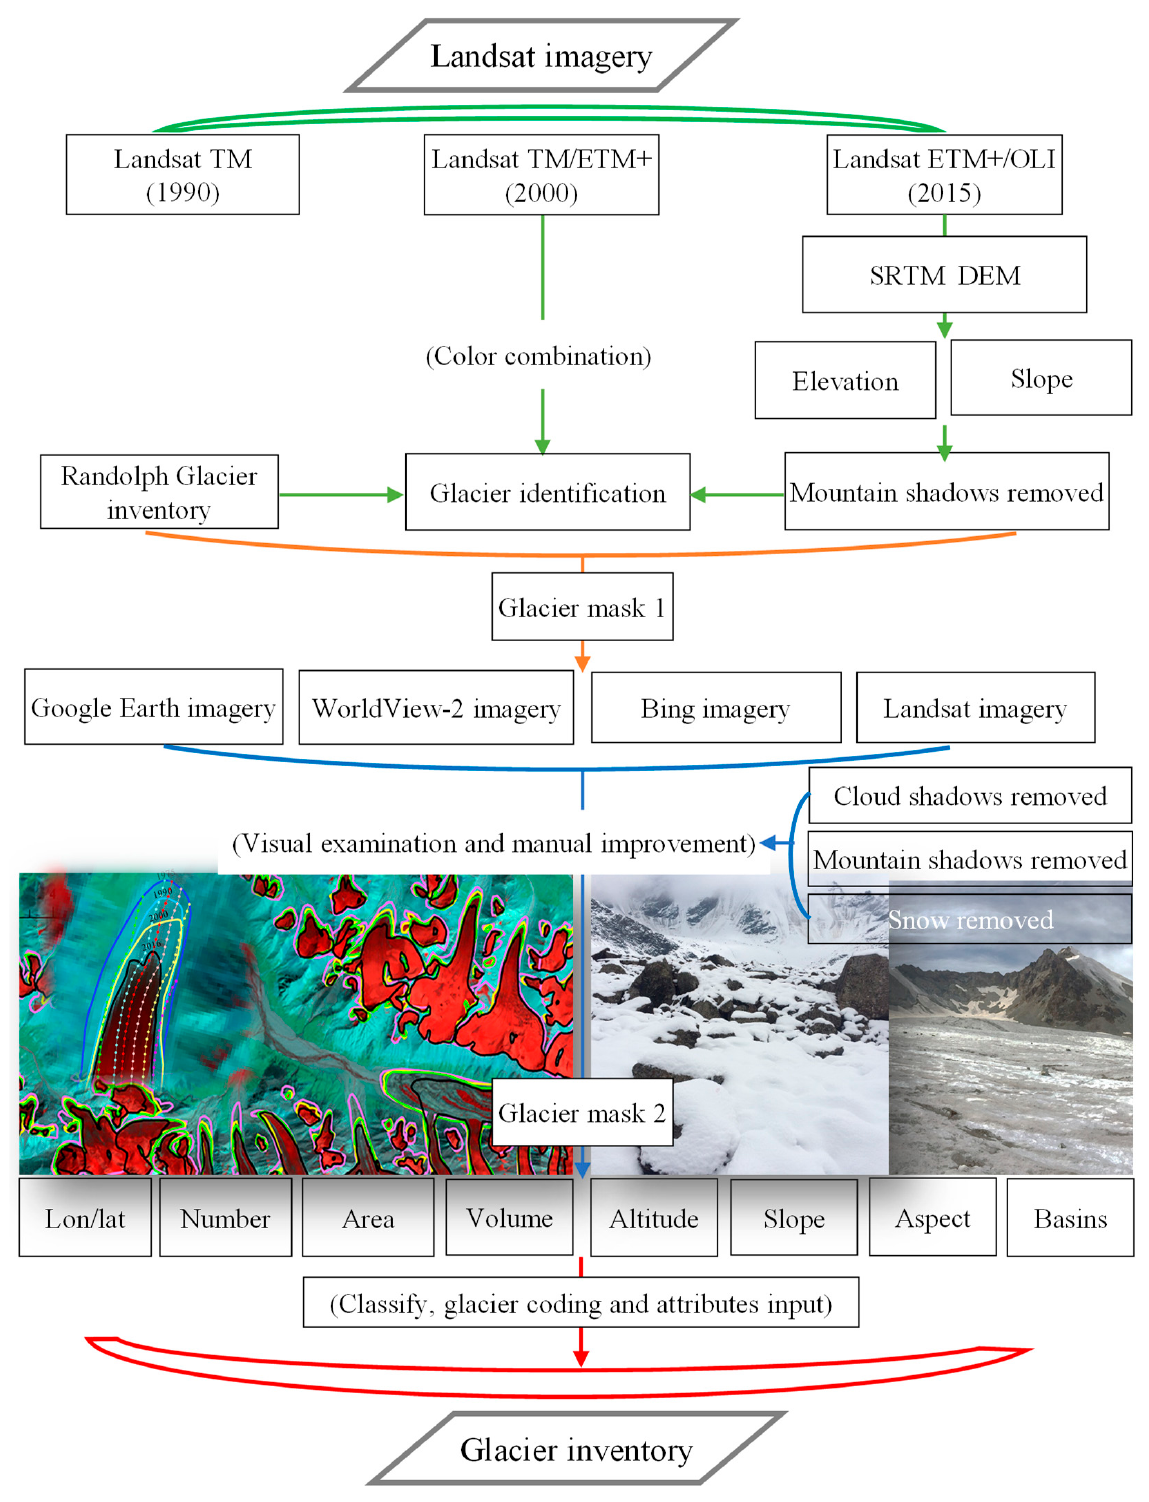
Figure 2. Flow chart showing process used for extracting glacier inventory in the study.